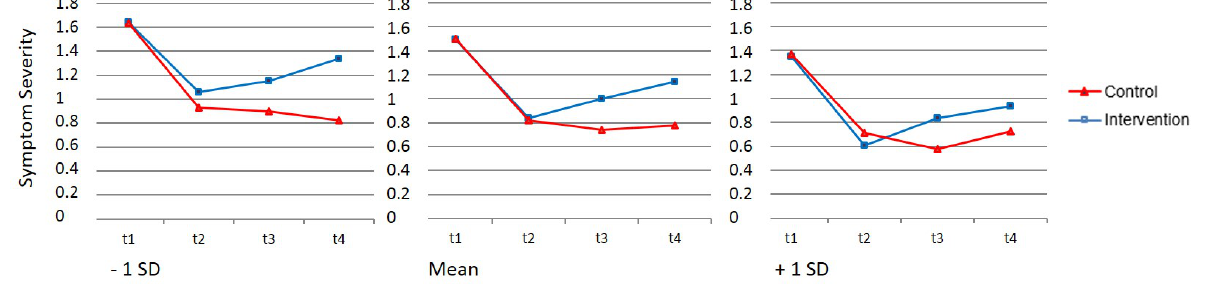
Study participants were significantly younger than nonparticipants (with an average difference of 1.7 years, t =–3.54, P <.001), had higher self-efficacy ( t 2135